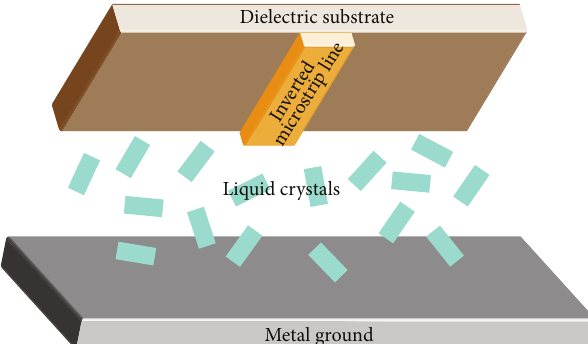
Figure 1: Idea structure of the novel circuit.